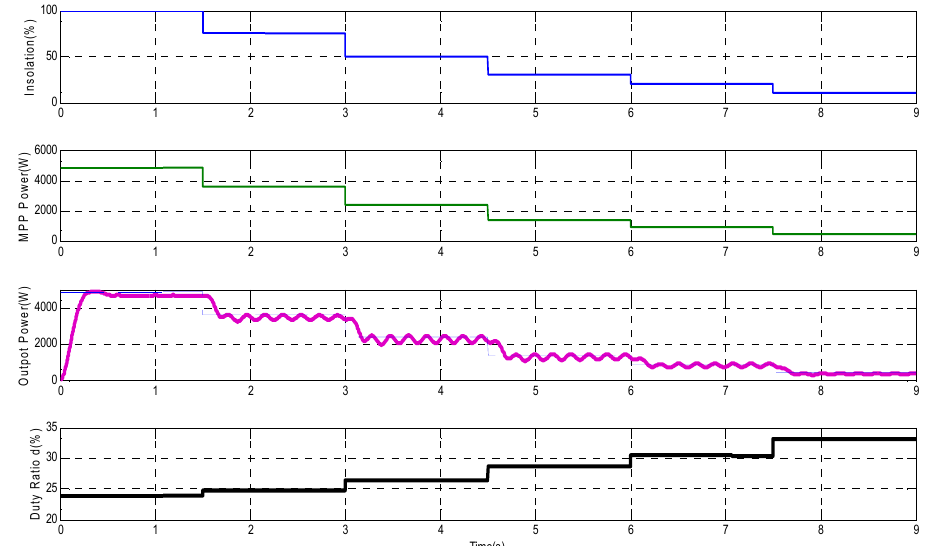
Figure 13. The MPP power, output power, and boost converter duty ratio ( d ) for the conventional MPPT system at step insolation changes.